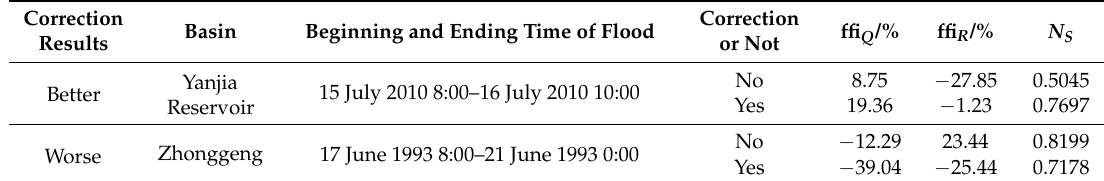
Table 18. Statistics of typical complex floods.